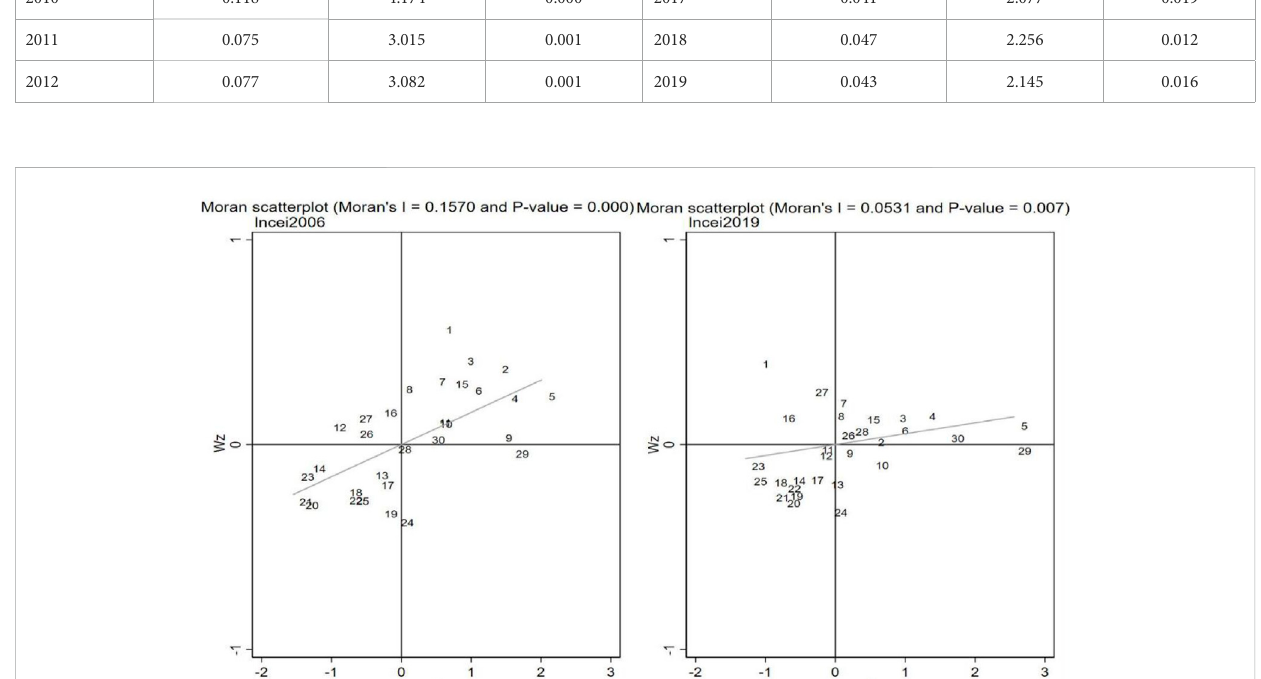
FIGURE 1 Scatter plots of the local Moran ’ s I index for lnCEI in 2006 and 2019. Note: The numbers 1 – 30 in the chart represent Beijing (1), Tianjin (2), Hebei (3), Shanxi (4), Inner Mongolia (5), Liaoning (6), Jilin (7), Heilongjiang (8), Shanghai (9), Jiangsu (10), Zhejiang (11), Anhui (12), Fujian (13), Jiangxi (14), Shandong (15), Henan (16), Hubei (17), Hunan (18), Guangdong(19), Guangxi (20), Hainan (21), Chongqing (22), Sichuan (23), Guizhou (24), Yunnan (25), Shaanxi (26), Gansu (27), Qinghai (28), Ningxia (29) and Xinjiang (30), respectively.